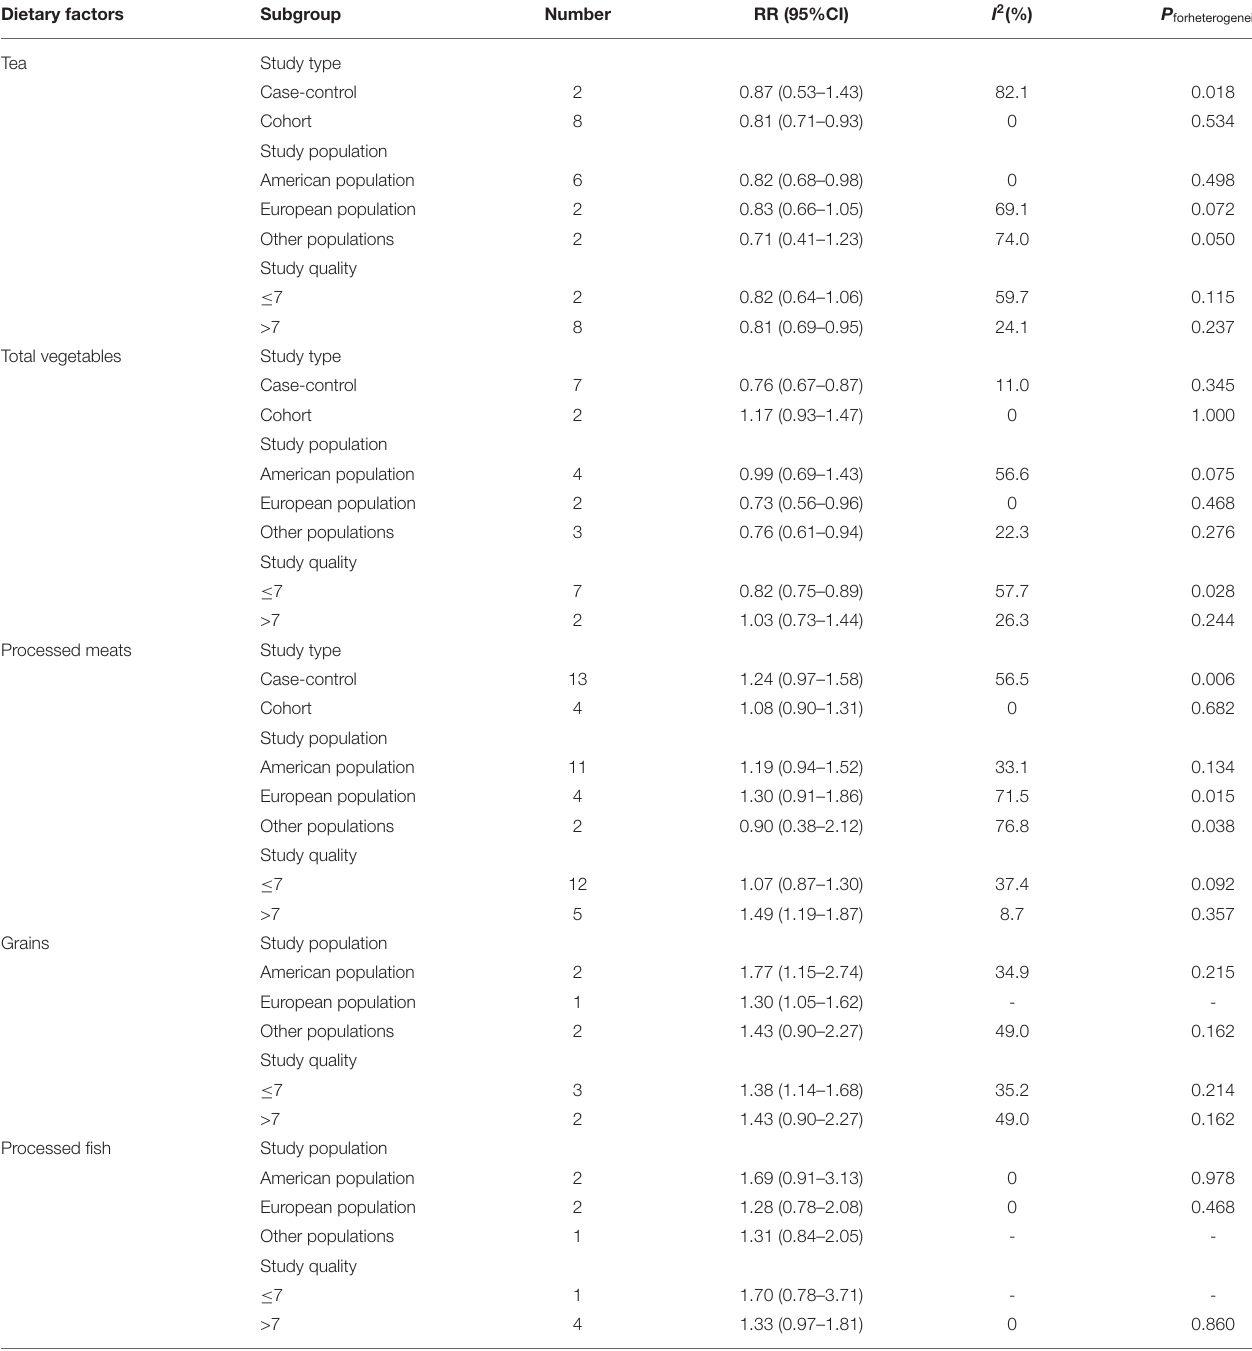
TABLE 3 | A subgroup analysis for the association between dietary factors and glioma. Dietary